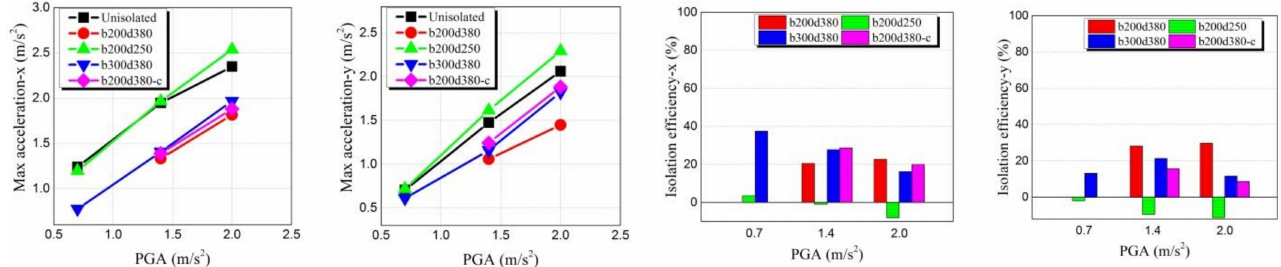
Figure 28. The maximum acceleration responses and isolation efficiency under 061CHC (low- frequency) ground